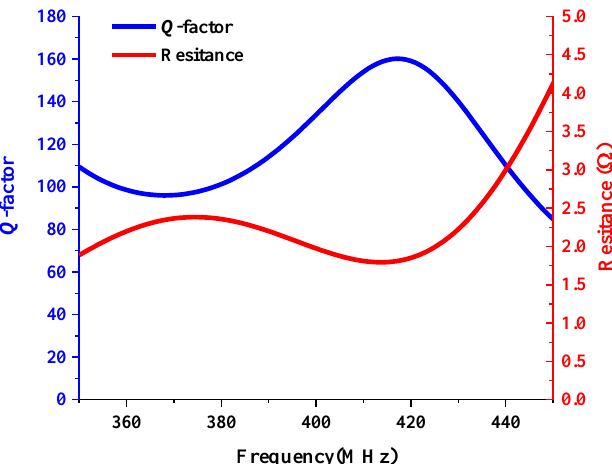
Figure 3. Simulated Q-factor and resistance of the optimised rectangular PSC.